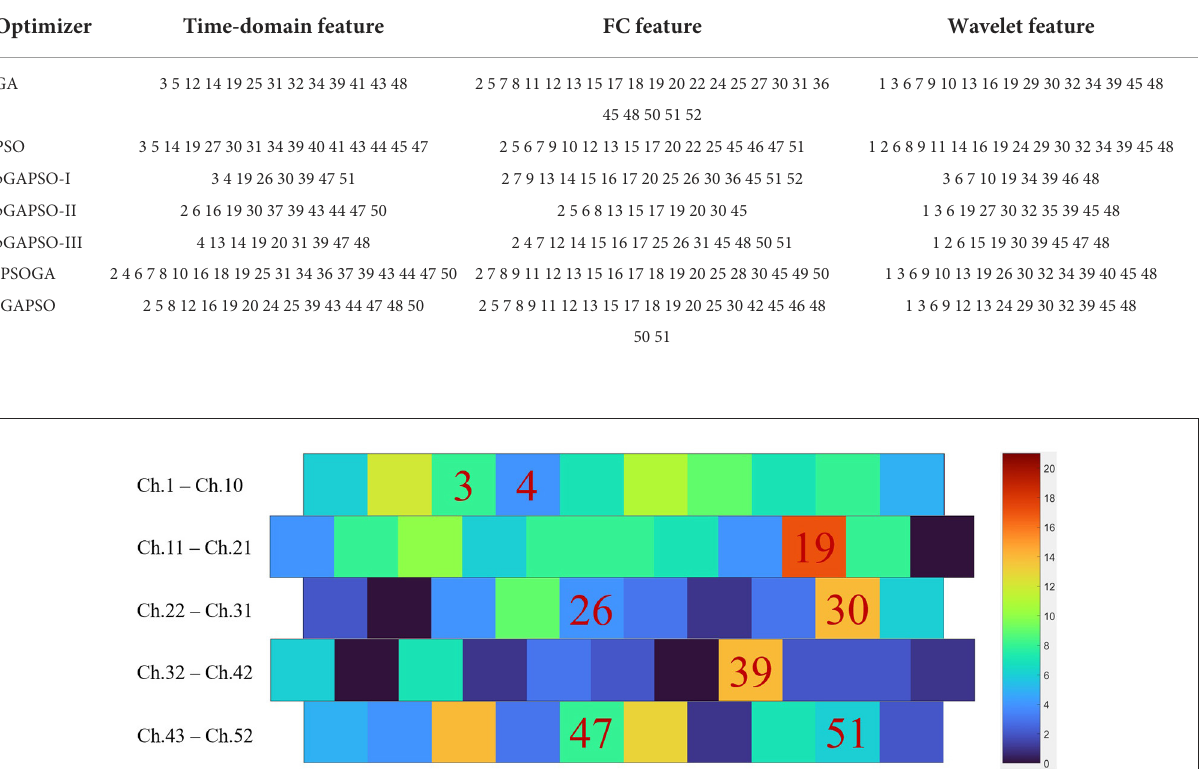
FIGURE7 The overlay heatmap of the channels in Table 2 according to the number of their occurrences. The specific 8 channels of the optimal combination were